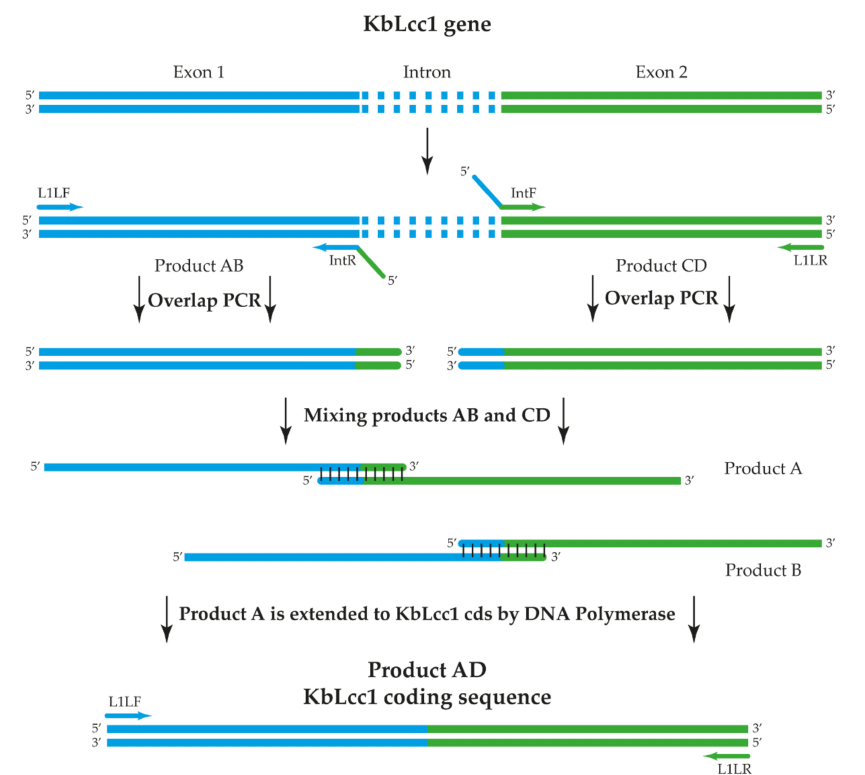
Figure 2. Scheme of Overall-Extension PCR reaction used to obtain of KbLcc1 laccase coding sequence.